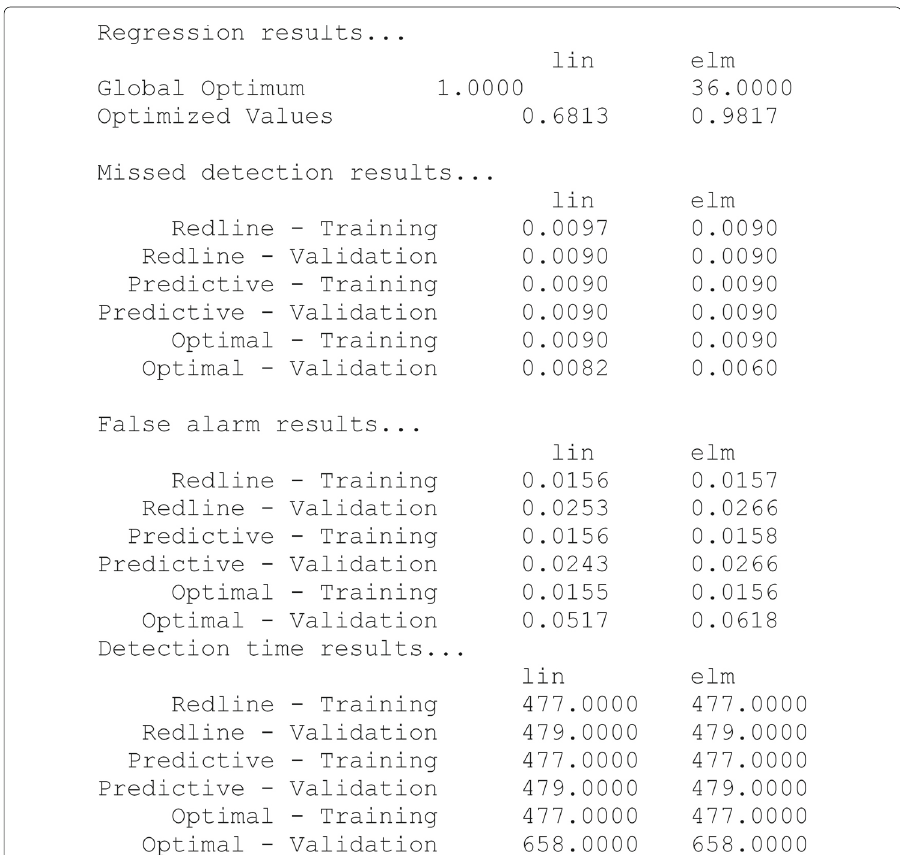
Fig. 5 ACCEPT results on MDR, FAR and DT for fault case “Open-windows-during-day”. Regularization coefficient is 1.0 and number of hidden neurons is 36. Missed Detection Rate (MDR) is shown first, then False Alarm Rate (FAR) and finally Detection Time